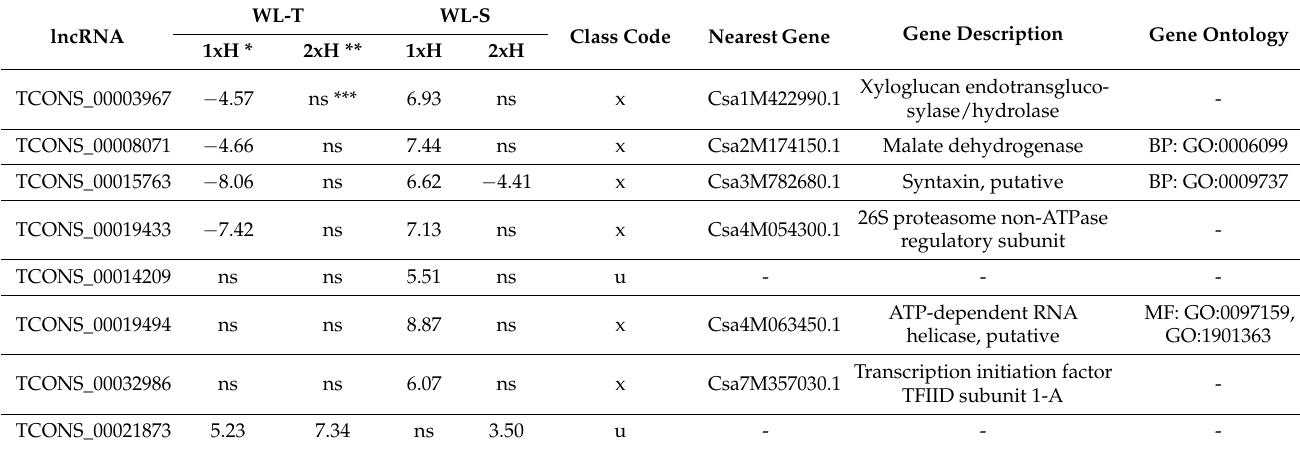
Table 1. List of lncRNA molecules selected for validation using qRT-PCR on the basis of the RNAseq data [7]. lncRNA